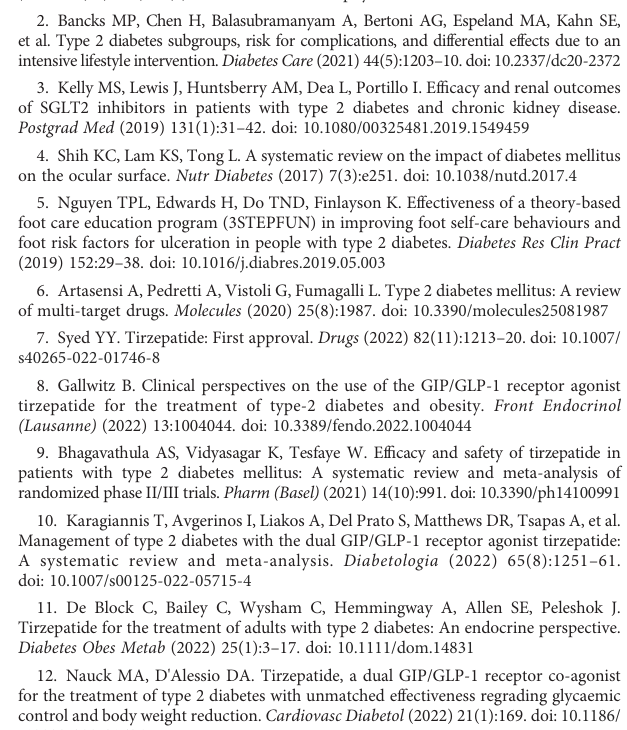
SUPPLEMENTARY FIGURE 2 Publication bias of safety for tirzepatide vs placebo (Funnel plot). (A) total adverse drug event (B) serious adverse drug event (C) gastrointestinal adverse drug event (D) nausea (E) vomiting (F) diarrhea (G) discontinuation by adverse drug event (H) hypoglycemia (I) injection-site reaction.